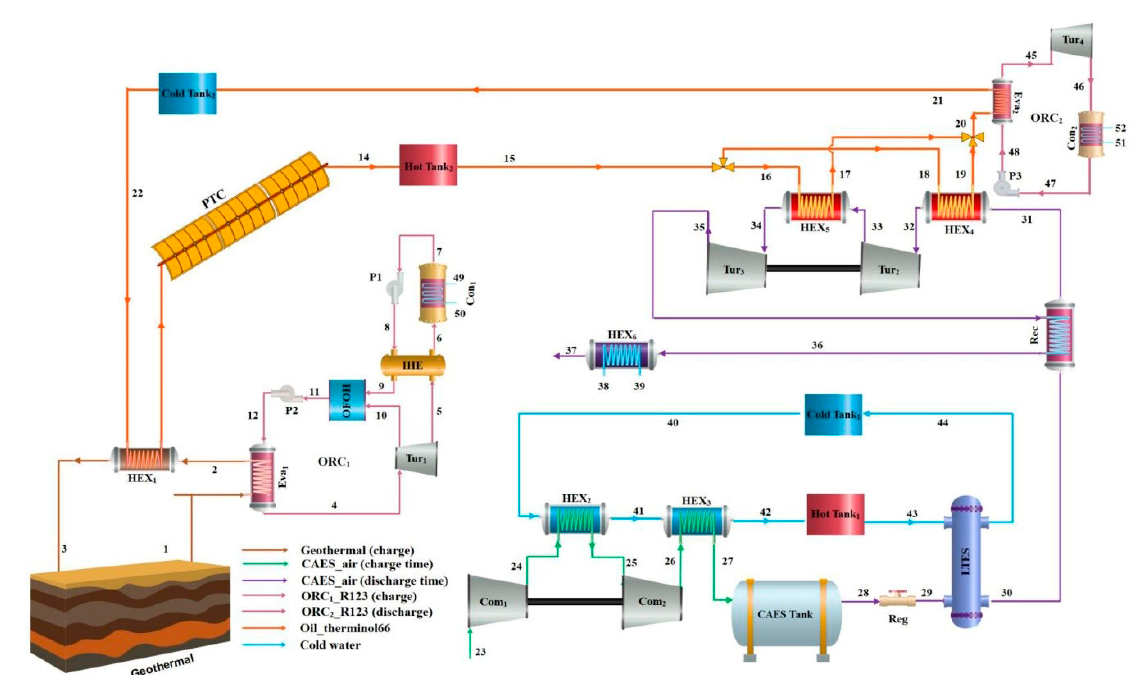
Figure 12. Schematic of the designed compressed air energy storage system [125], reused with permission from Elsevier (license number 5491450180668).